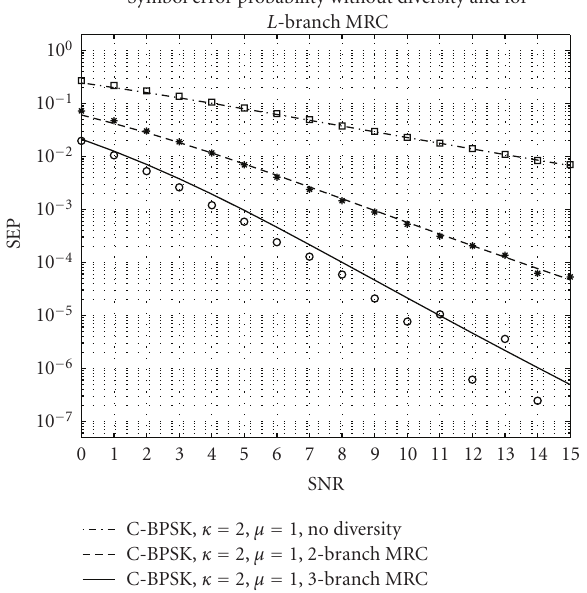
Figure 17: BEP/SEP for coherent detection, L = 1, 2, 3. Symbol error probability without diversity and for